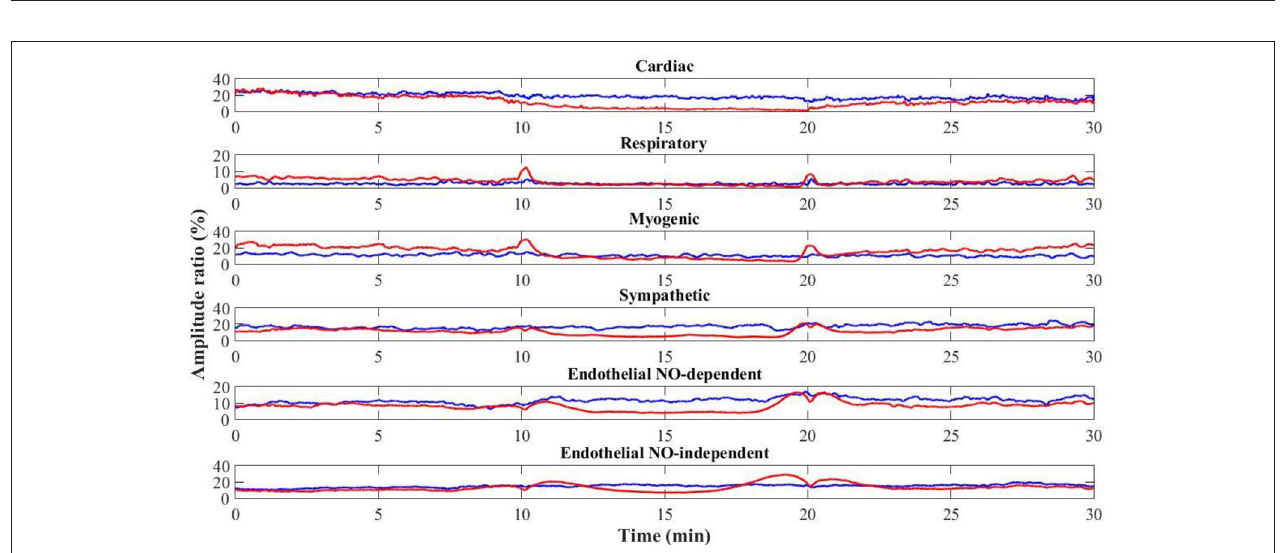
FIGURE 5 | Time evolution of the mean ( N 12) PPG signal components for the control (blue) and test (red) feet throughout the protocol (baseline: 0–10min; = challenge: 11–20min; recovery: